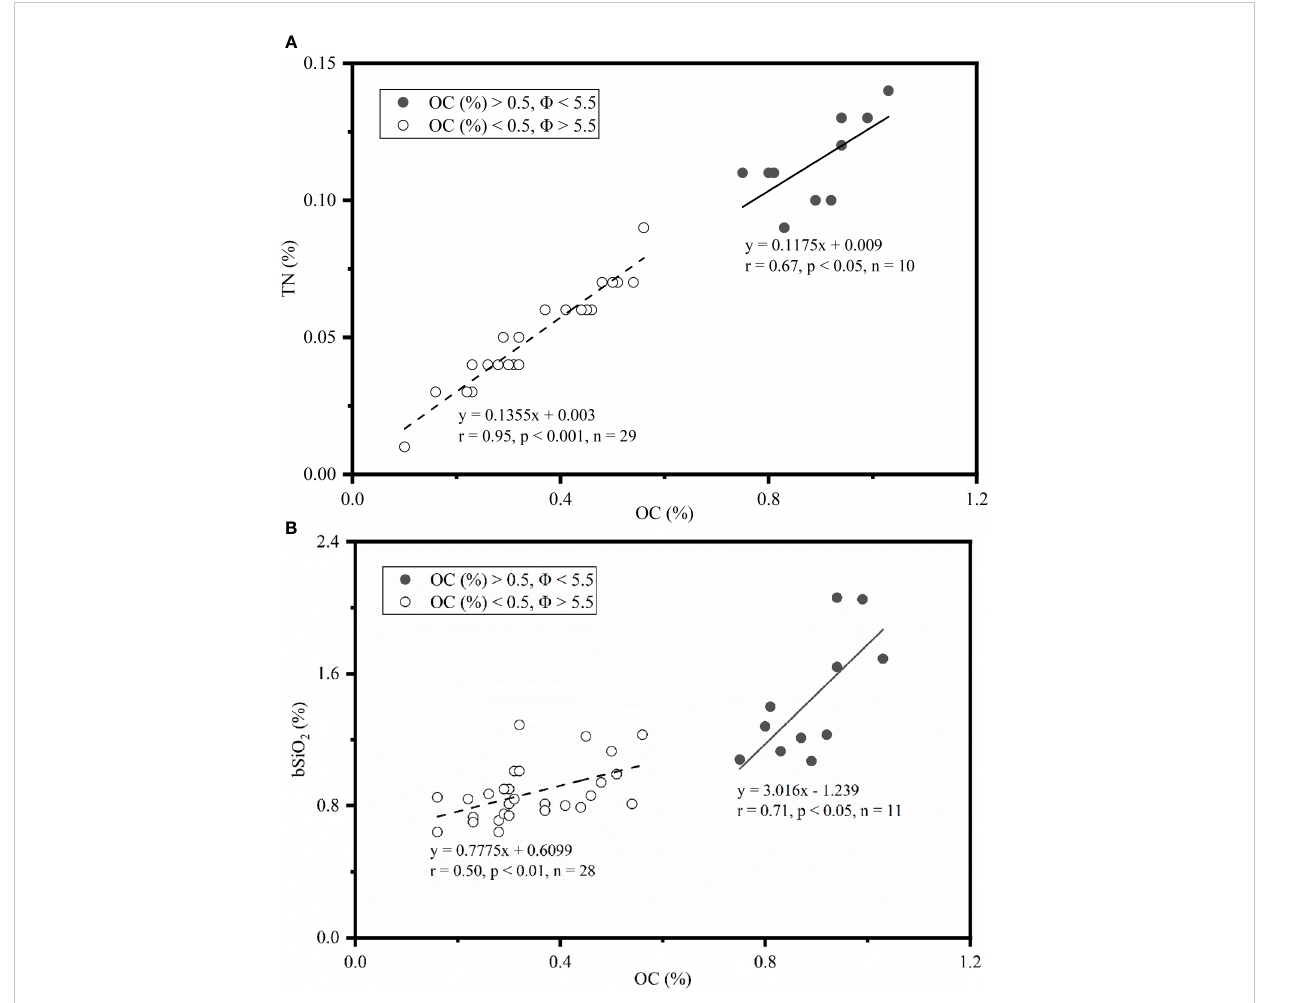
FIGURE 7 Correlations between (A) OC (%) and TN (%), and (B) OC (%) and bSiO 2 (%) contents in sediments with Pearson correlation coef fi cients (r) and regression curves. Solid and dashed lines denote the regression trends with OC > 0.5 and F < 5.5, and OC<0.5 and F > 5.5,